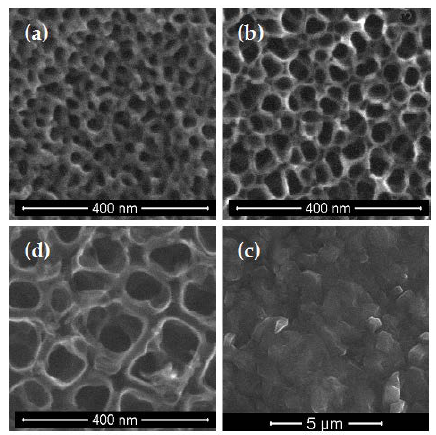
Figure 7. SEM images of TNT4 ( a ); TNT6 ( b ); TNT18 ( d ) heated at 573 K ; and TNT6 ( c ) heated at